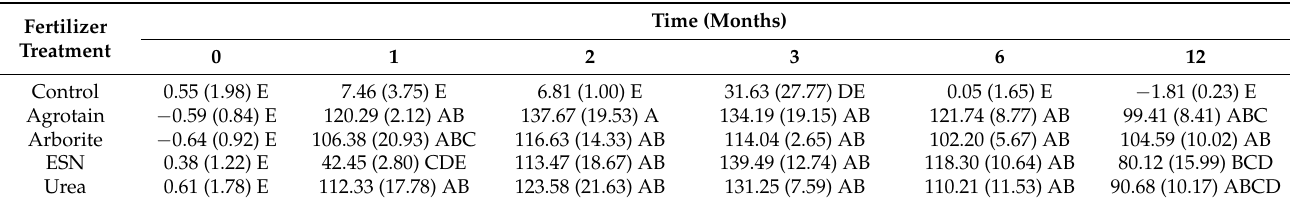
Table 7. Responses of δ 15 N (‰) of litter to fertilization treatments and time. Table entries are means ( ± standard error of the mean) for each fertilizer treatment × time combination ( n = 8). Means throughout the table marked with the same letters did not differ significantly ( α =